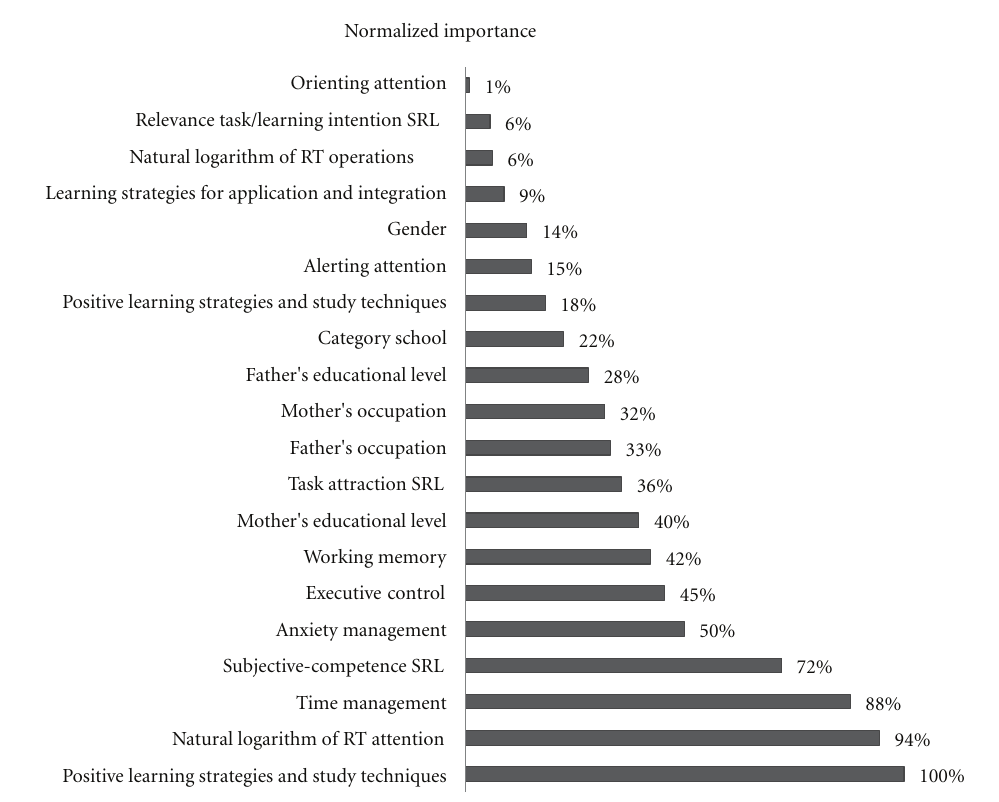
Figure 3: Normalized importance of the top variables participating in the model for the predictive classification of the middle 30% of scores in the mathematics